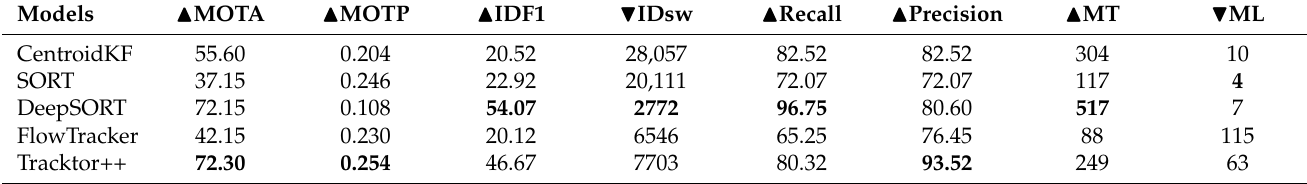
Table 7. Averaged results of trackers across all datasets (DanceTrack, SportsMOT, MOT17, RI-HB-PT), i.e., averaged results from Table 6. The best results according each metrics are marked in